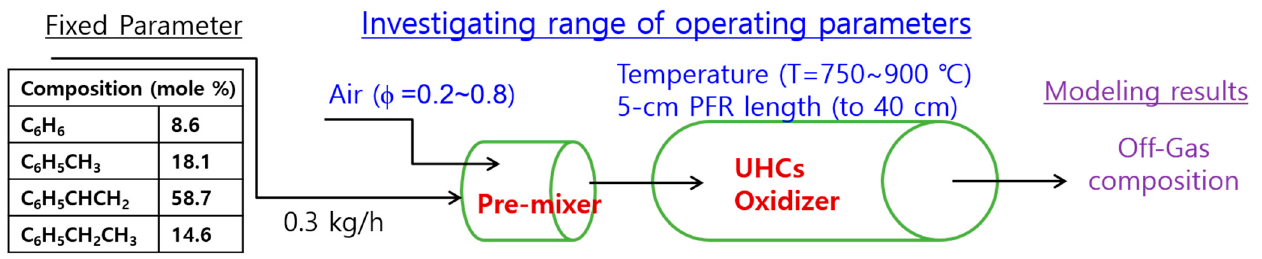
Figure 8. Simulated conditions for the determination of the unburned hydrocarbon (UHC) combustor operating condition.